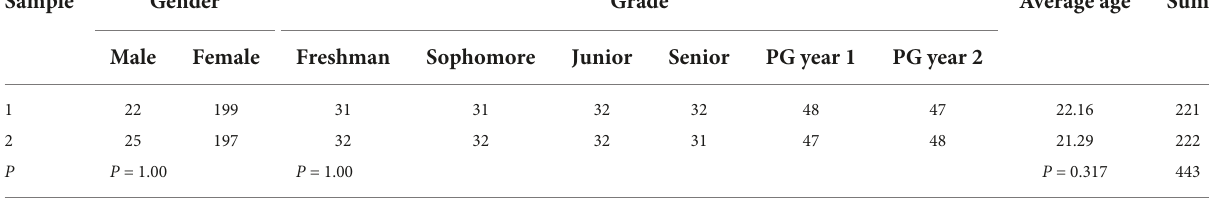
TABLE 3 Demographic information of the participants.